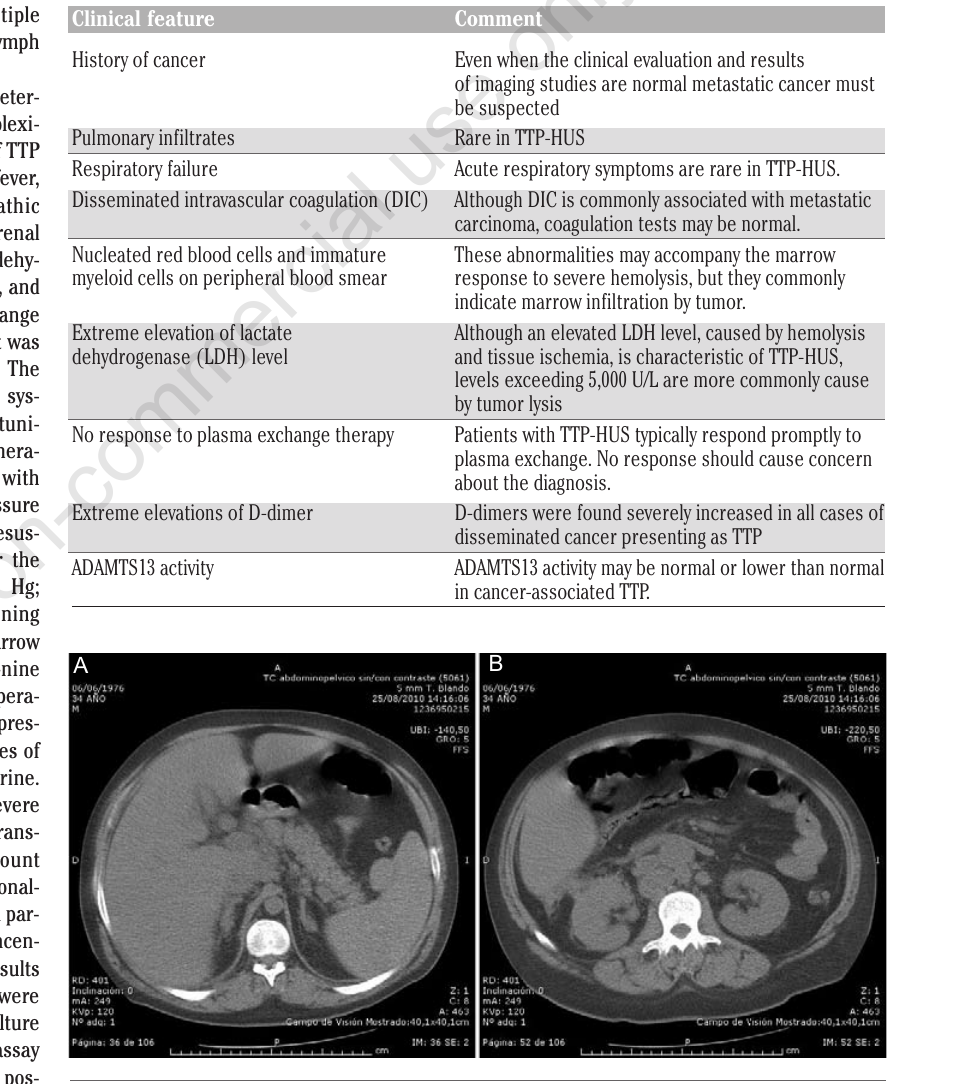
Figure 1. Abdominal CT scan demonstrates A) pathological hepatic lymph nodes and B) retroperitoneal lymph nodes.